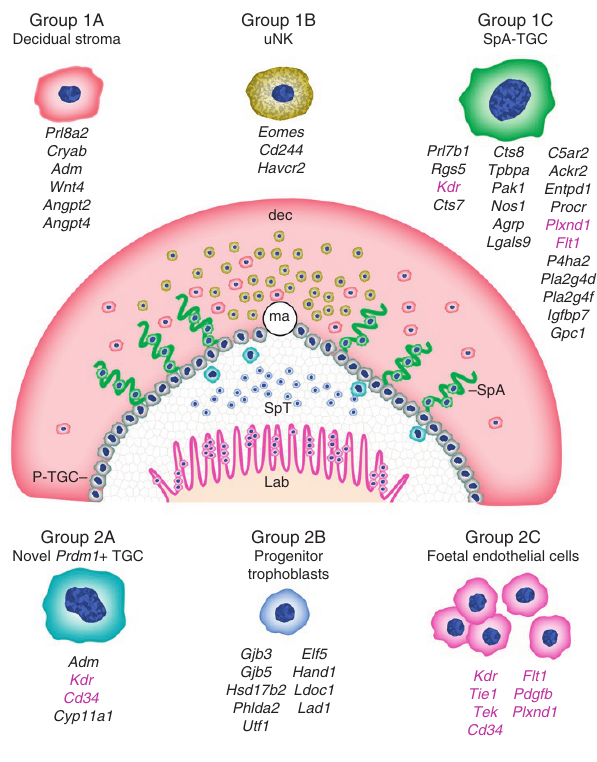
Figure 8 | Summary of key marker genes identifying each cell type. Overview summary of the locations of the profiled cell types within E9.5 placenta and key identified markers discussed above are indicated. Vascular markers are in pink. Abbreviations: dec, decidua; ma, maternal artery; SpA, spiral artery; SpT, spongiotrophoblast layer; lab, labyrinth; P-TGC, parietal trophoblast giant